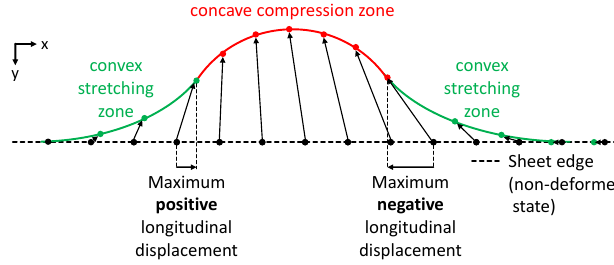
Figure 16. Displacement paths of the concave/convex shaped profile edge.